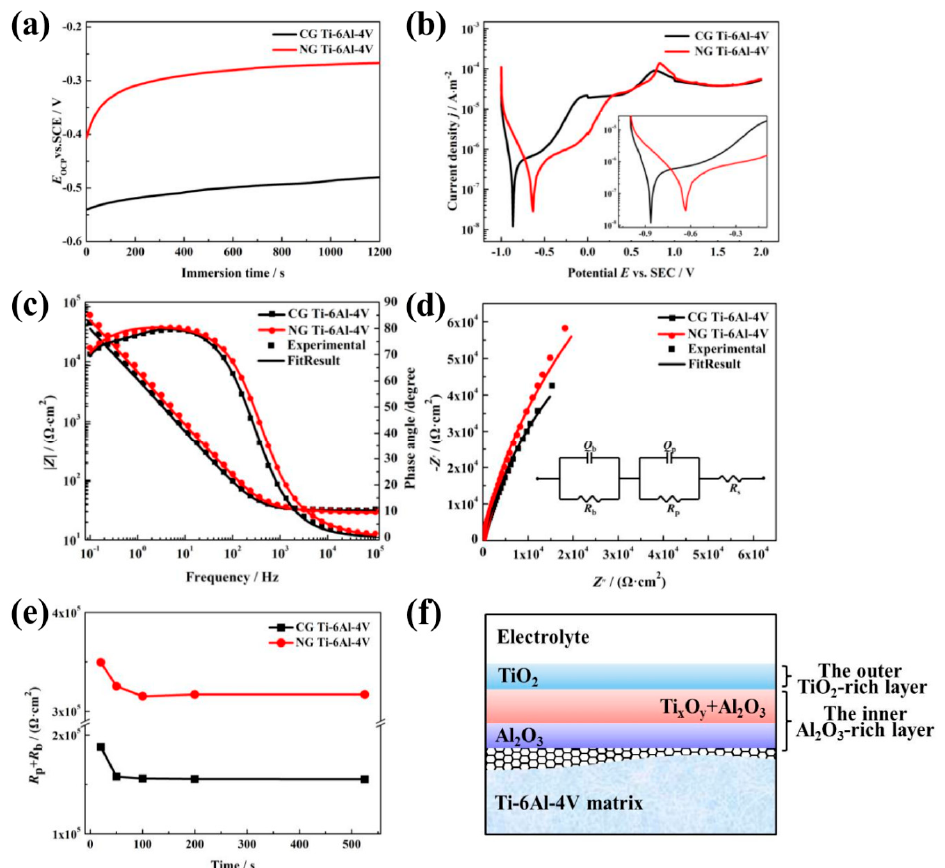
Figure 2. Open circuit potential (OCP) plots ( a ), PDP curves ( b ), Bode plots ( c ), and the corresponding Nyquist plots ( d ) of NG and CG Ti–6Al–4V samples in SBF solutions at 37 °C. Variation of R p + R b and testing time in applying passive potential ( e ), and equivalent electrical circuit (insert in ( d )) with R s ( Q p R p )( Q b R b ) model used to fit the impedance spectra. Schematic diagrams ( f ) of passive layers formed on NG and CG Ti–6Al–4V